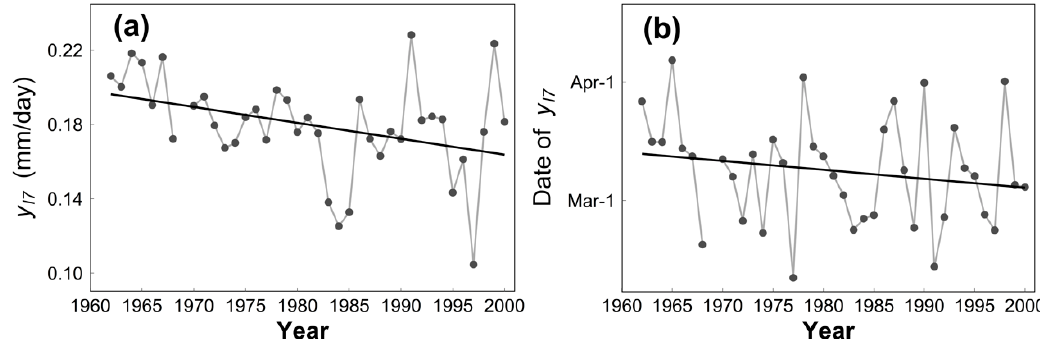
Figure 5. Trends in ( a ) annual lowest 7-day flow ( y l 7 ) and ( b ) the occurrence date of y l 7 in the Yarlung.